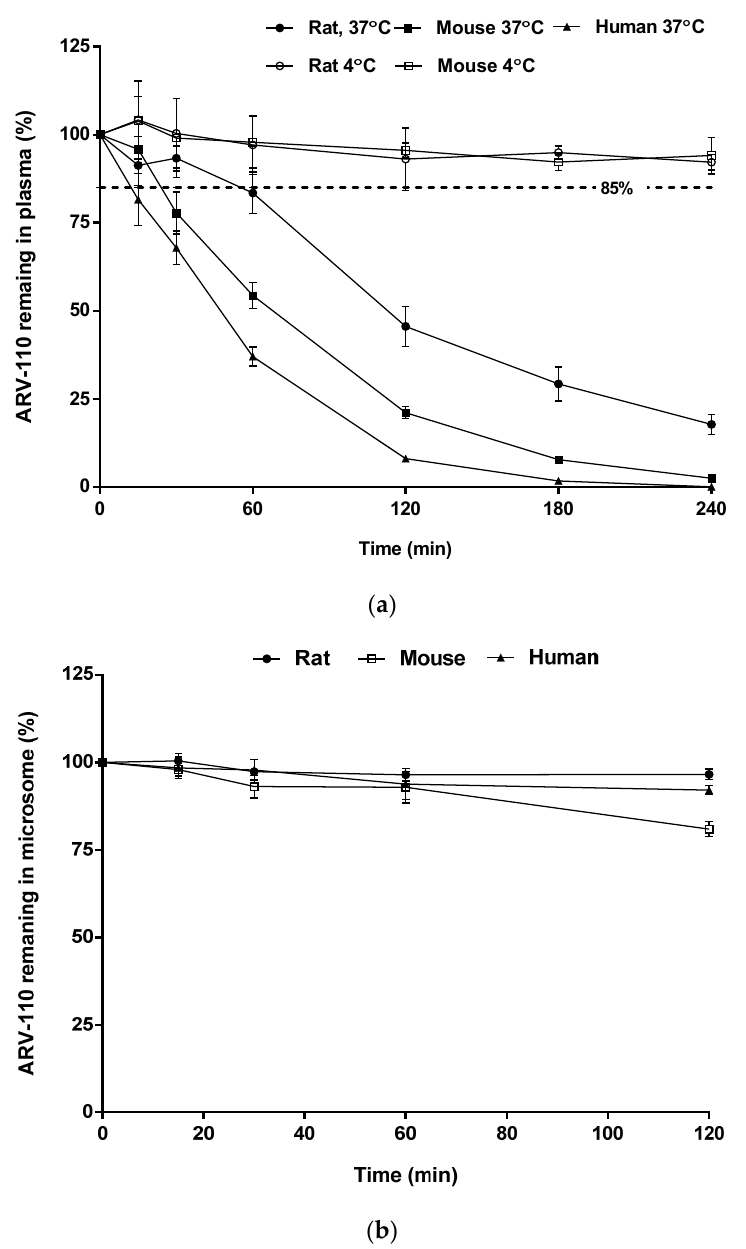
Figure 4. Residual ARV-110 levels (%) in rat plasma at 4 °C ( ○ ), rat plasma at 37 °C ( ● ), mouse plasma at 4 °C ( □ ), mouse plasma at 37 °C ( ■ ) and human plasma at 37 °C ( ▲ ) ( a ); and in rat ( ● ), mouse ( □ ), and human ( ▲ ) hepatic microsomes ( b ). Data are presented as mean ± SD ( n = 3).